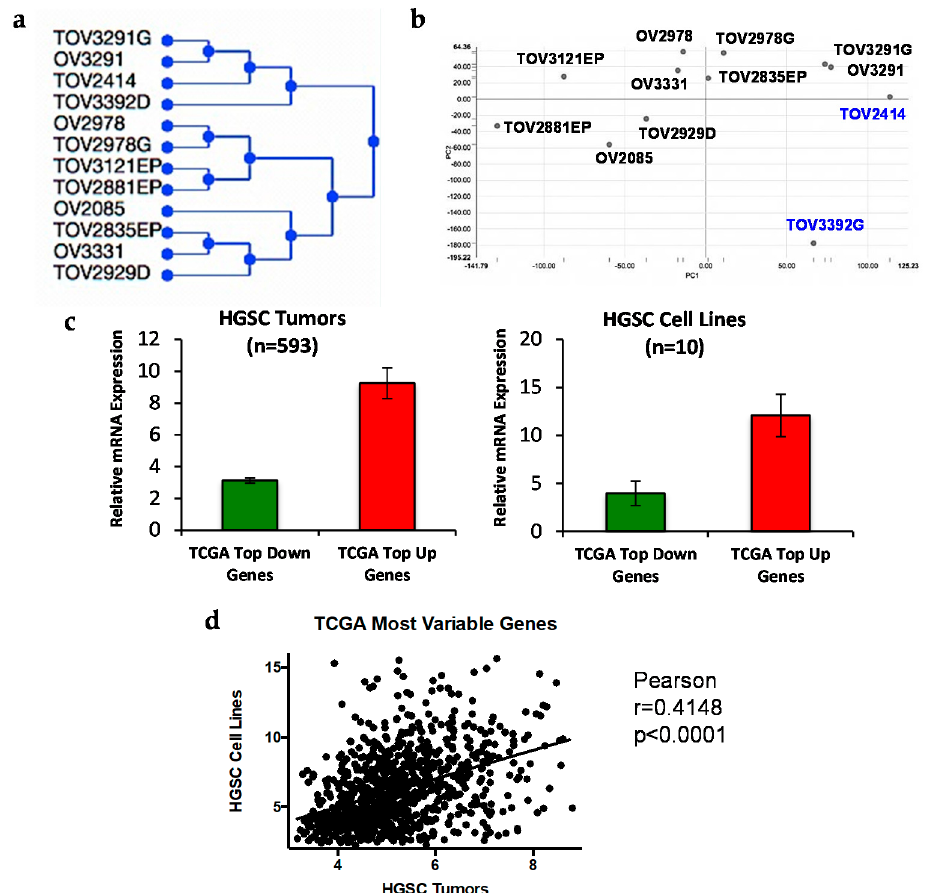
Figure 2. Gene expression analysis of our EOC cell lines, and comparison to tumor samples from the TCGA high-grade serous carcinoma (HGSC) dataset. ( a , b ) The complete normalized gene expression data for each of the 12 analyzed cell lines (10 from this work plus the two matched tumor cell lines from patients 2978 and 3291) was subjected to ( a ) unsupervised hierarchical clustering and ( b ) principal component analysis (PCA) using the TM4 MeV software. ( c ) Expression of the 1000 most up- or downregulated genes in HGSC tumors from the TCGA cohort ( left ) was verified in 10 of our HGSC cell lines (8 from this work plus the two matched TOV2978G and TOV3291G cell lines) ( right ) and plotted as bar graphs (mean ± SEM). ( d ) Expression of the 1000 most variably expressed genes in the TCGA HGSC cohort was verified in the 10 HGSC cell lines mentioned in ( c ), and Pearson correlation analysis was performed.